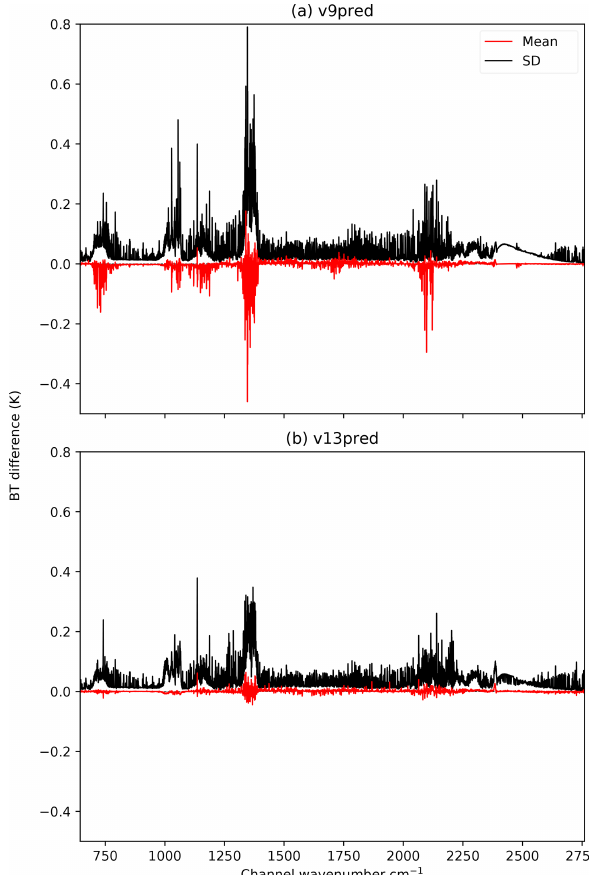
Figure 3. RTTOV vs. brightness temperatures calculated from channel-integrated LBL transmittances for IASI (a) v9 and (b) v13 predictors with all variable gases for the 83 training